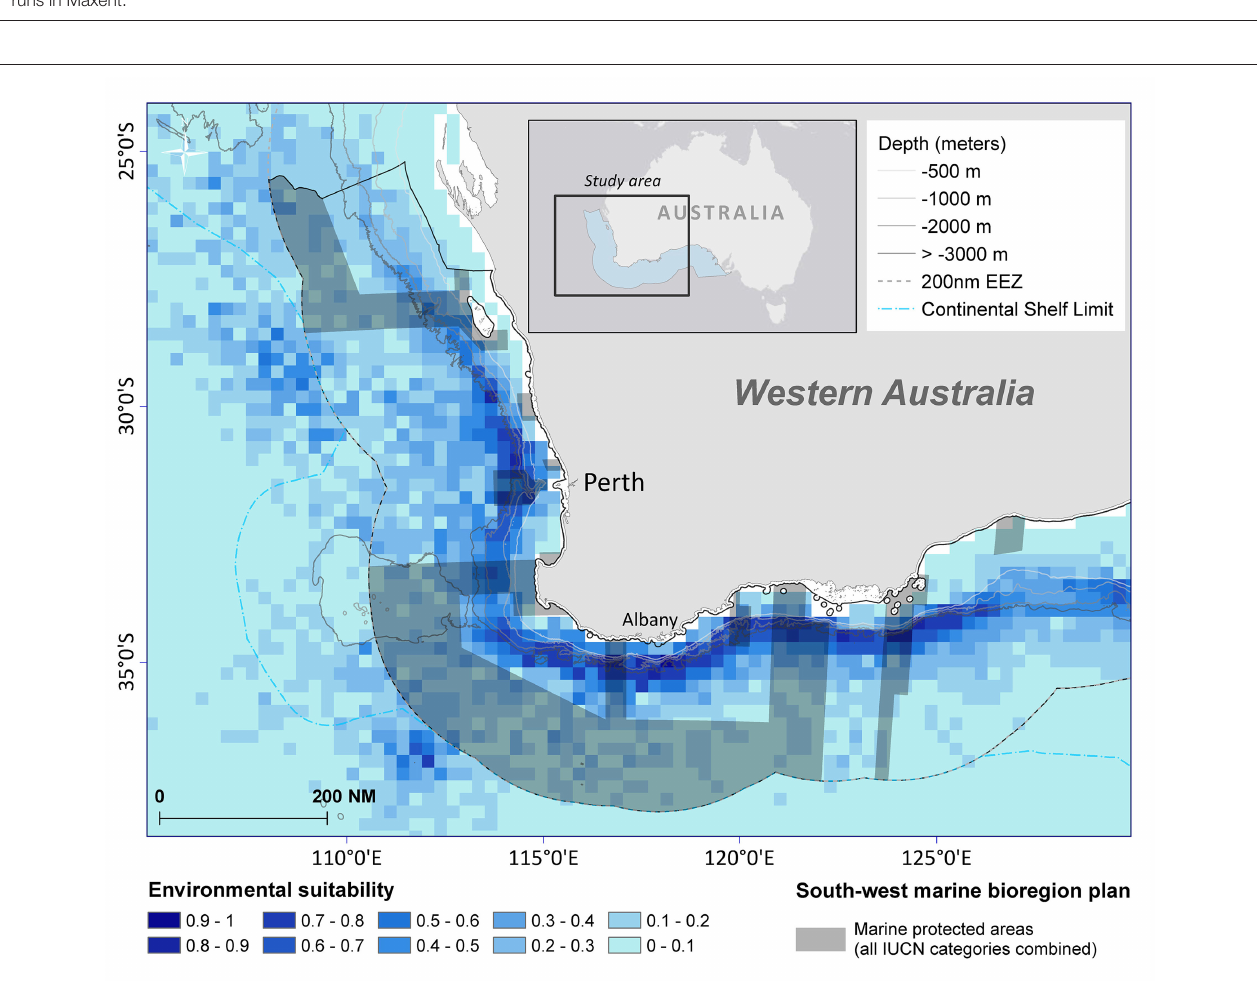
FIGURE 10 | Sperm whale distribution model of suitable habitat displayed in 15 nautical mile grid cells for summer/autumn seasons combined at 95% confidence level. The boundaries of the south-west marine bioregion proposed protected areas (shaded in dark gray) displayed over the species distribution model.